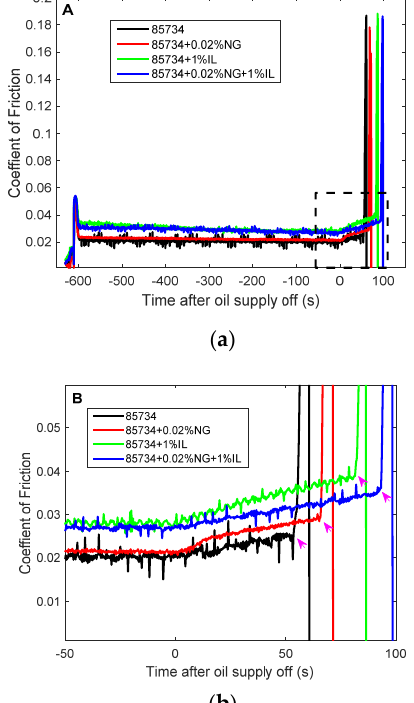
Figure 2. Coefficient of friction during ball-on-disk, loss-of-lubrication experiments. ( a ) Entire experiment, ( b ) Zoom in within the